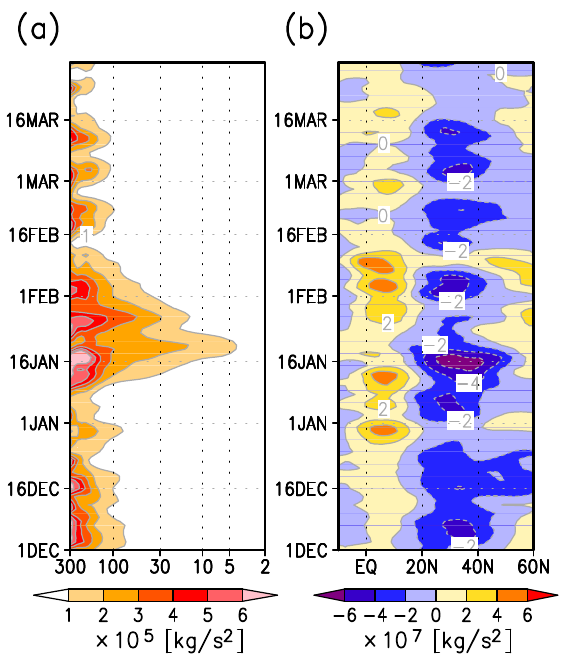
Fig. 10. (a) Time-altitude section of the first vertical component of the Eliassen-Palm (EP) flux F (z) averaged over 40 ◦ N–70 ◦ N. (b) 1 Time-latitude section of the second meridional component of the averaged between 125 and 100hPa. EP flux F (φ) 2 Fig. 11. Maps of the horizontal component of Plumb’s (1985) 3-D wave activity flux (vectors; m 2 s − 2 ) and vertical component (color shading; m 2 s − 2 ) averaged between 125 and 100hPa on (a) 12 Jan- uary 2009, (b) 15 January 2009, (c) 18 January 2009, and (d) 21 January 2009. Vectors and colors are multiplied by cos φ